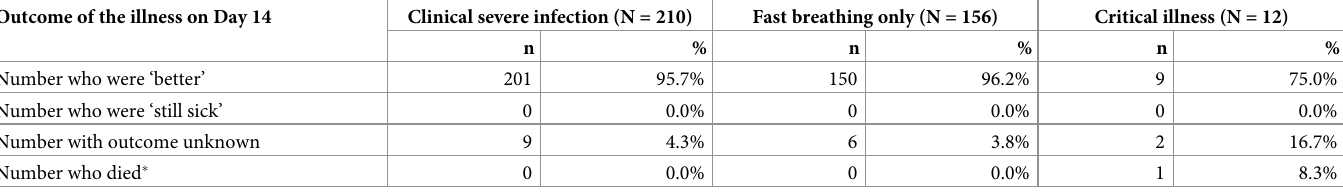
Table 4. Outcome of the illness on day 14 for all patients (n = 378).